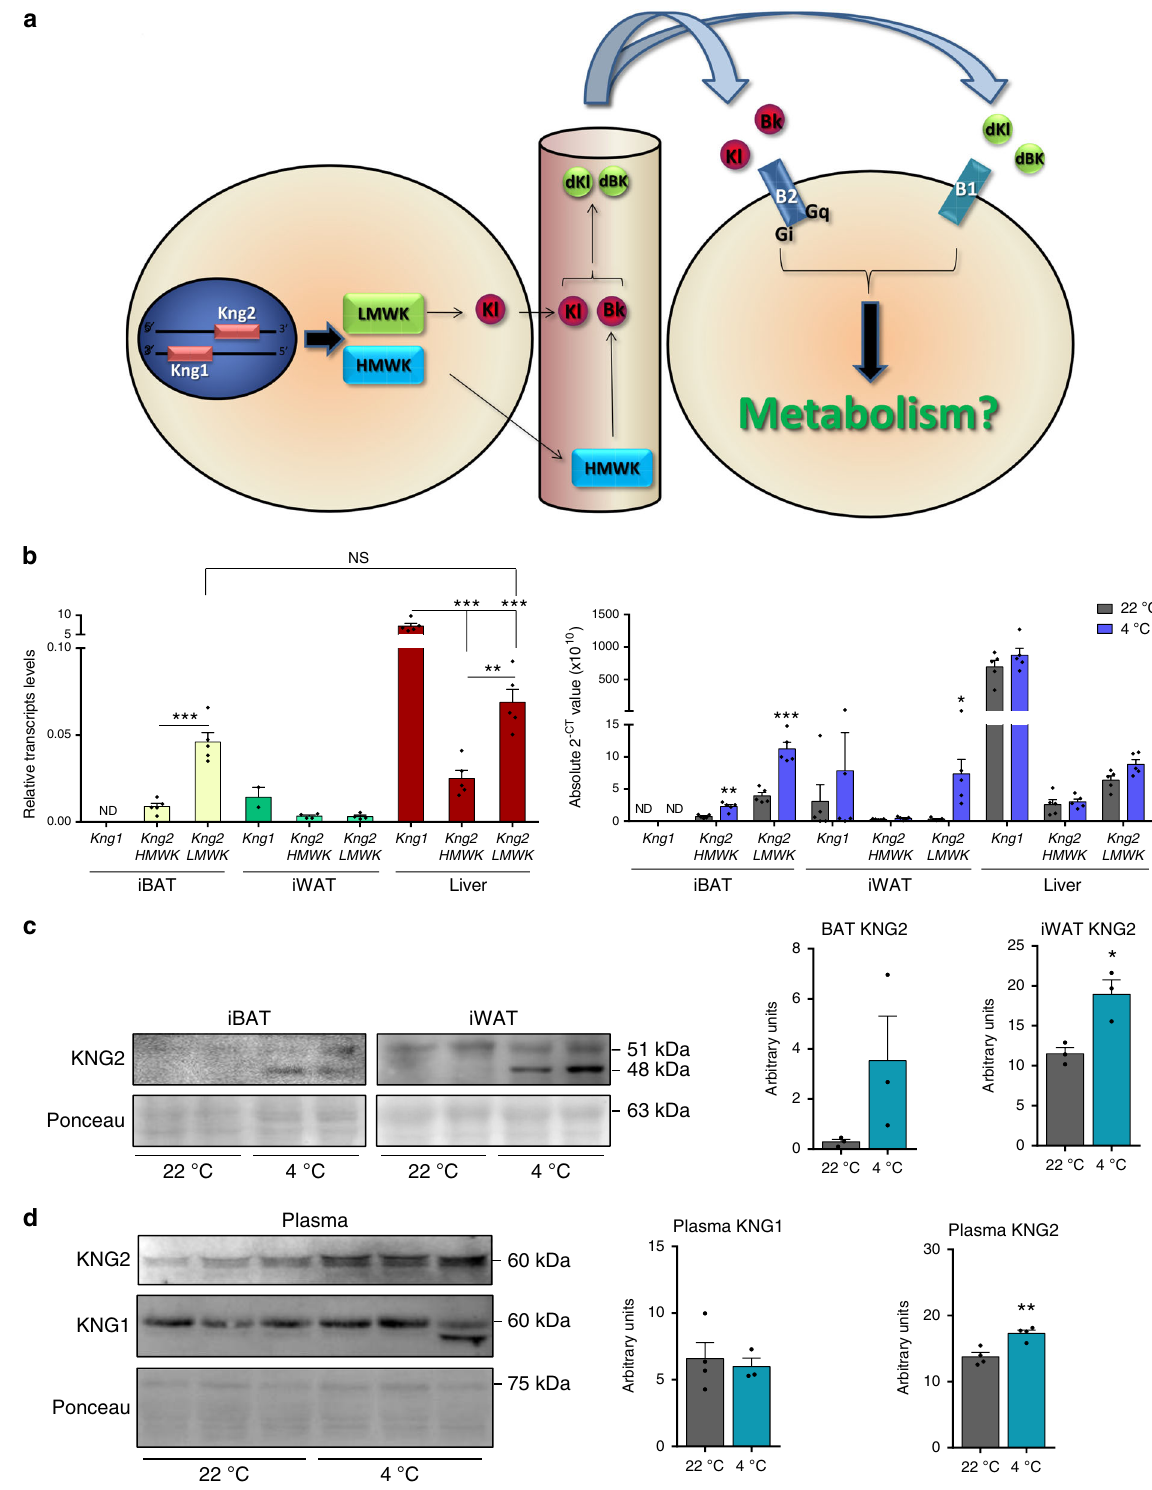
Fig. 1 Differential expression of Kng genes in tissues. a Representation of the Kng system. LMWK, low molecular weight kininogen; HMWK, high molecular weight kininogen; Kl, kallidin; Bk, bradykinin; Dkl, [Des-Arg9]-kallidin; Dbk, [Des-Arg9]-bradykinin; B2, kinin B2 receptor; B1, kinin B1 receptor. b mRNA expression of the different Kngs in iBAT, iWAT and liver of 2 months old Swiss mice ( n = 5 animals; except for iWAT Kng2 HMWK and LMWK left graph where n = 4). mRNA expression of Kngs in fat depots and liver of 2 months old Swiss mice exposed to cold or control room temperature for 1 week ( n = 5 animals). c KNG2 protein expression in iBAT and iWAT of mice exposed to RT or 4 °C ( n = 3 animals). d KNG1 and -2 protein expression in plasma of WT mice exposed to cold for 1 week ( n = 4 animals; except for KNG1 4 °C where n = 3). ND, not detectable; NS, not signi fi cant. Data are presented as means ± s.e.m. (bars). * P < 0.05, ** P < 0.01, and *** P < 0.001 versus corresponding controls. P -values determined by two ways ANOVA with Tukey ’ s post hoc test ( b left) and two-tailed unpaired Student ’ s t -test ( b right, c , d ). Source data are provided as a Source data fi